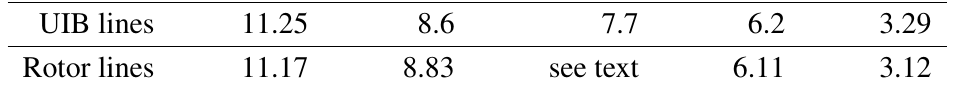
Table D1. Comparison of the observed UIB lines and the calculated rigid-rotor lines in µ